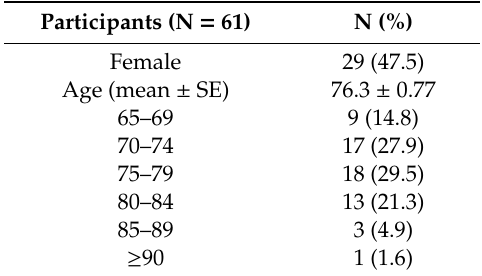
Table 1. Socio-demographic characteristics of